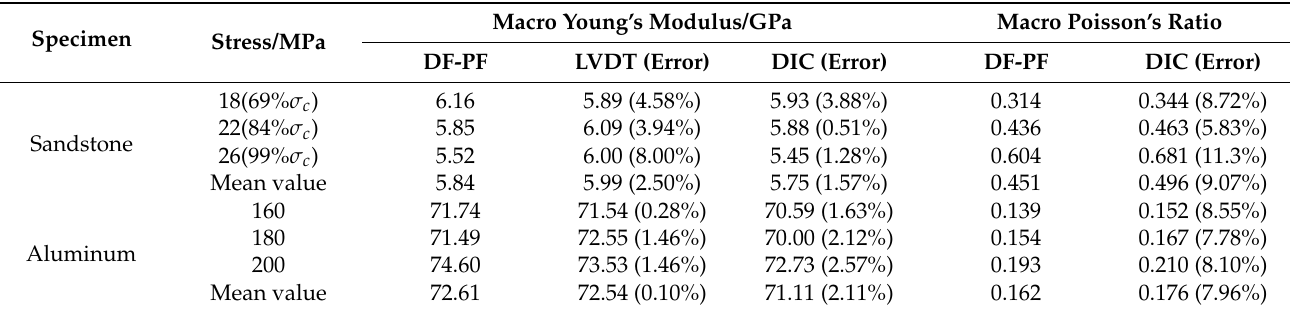
Table 4. Comparison of the inversion results and the conventional testing